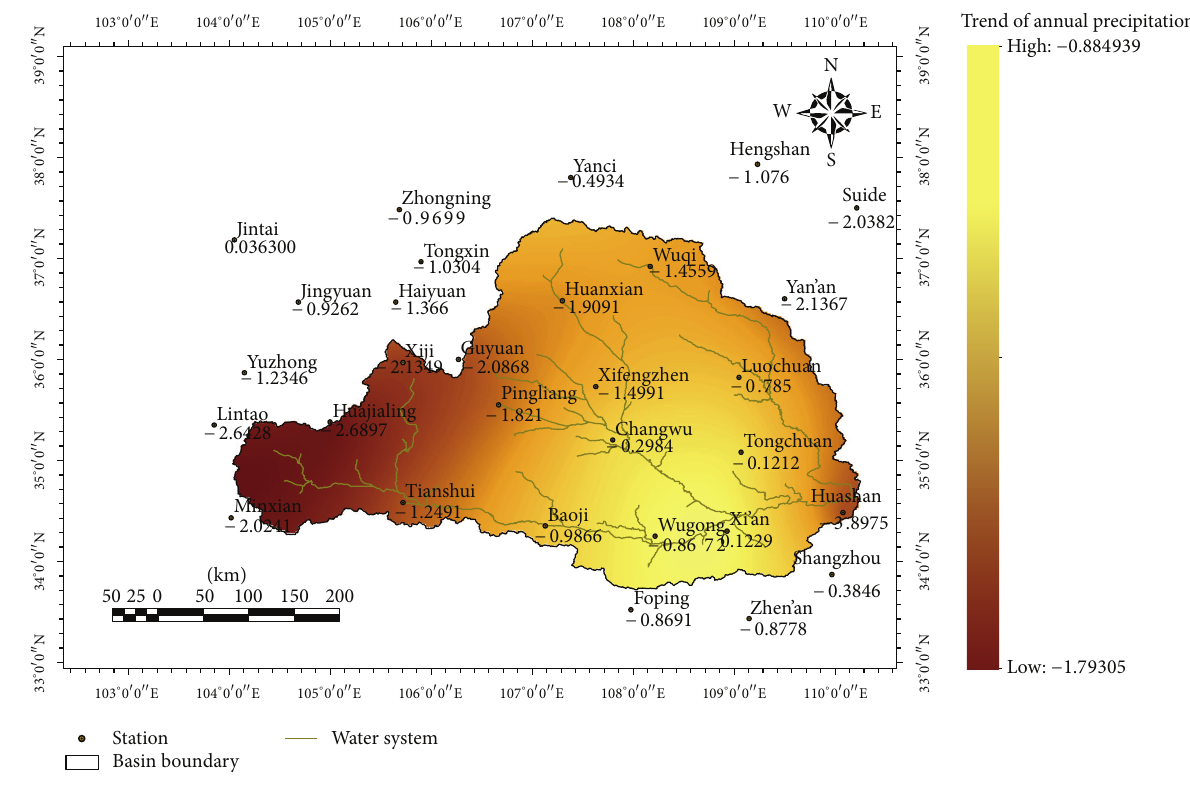
Figure 3: Annual precipitation trends in the Weihe basin. Table 1: Eigenvalues and their contributions to the variance of annual precipitation in the Weihe basin obtained from EOF decomposition. Initial eigenvalues Extraction sums of squared Component